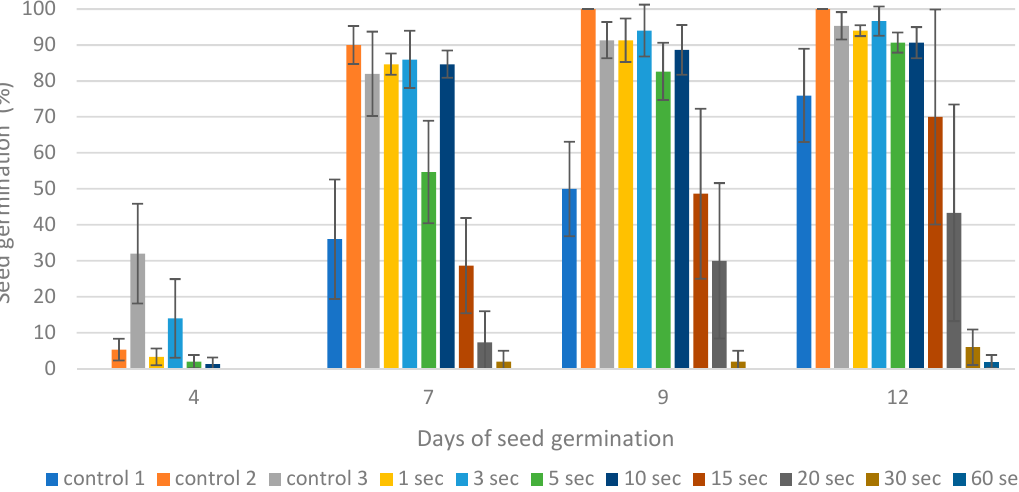
Figure 3. The percentage of Scots pine seed germination exposed to different times of non-thermal plasma treatment after the 4 th , 7 th , 9 th , and 12 th days of seed germination. Control 1, control 2, and control 3, see Figure 2. More details are given in the Methods.